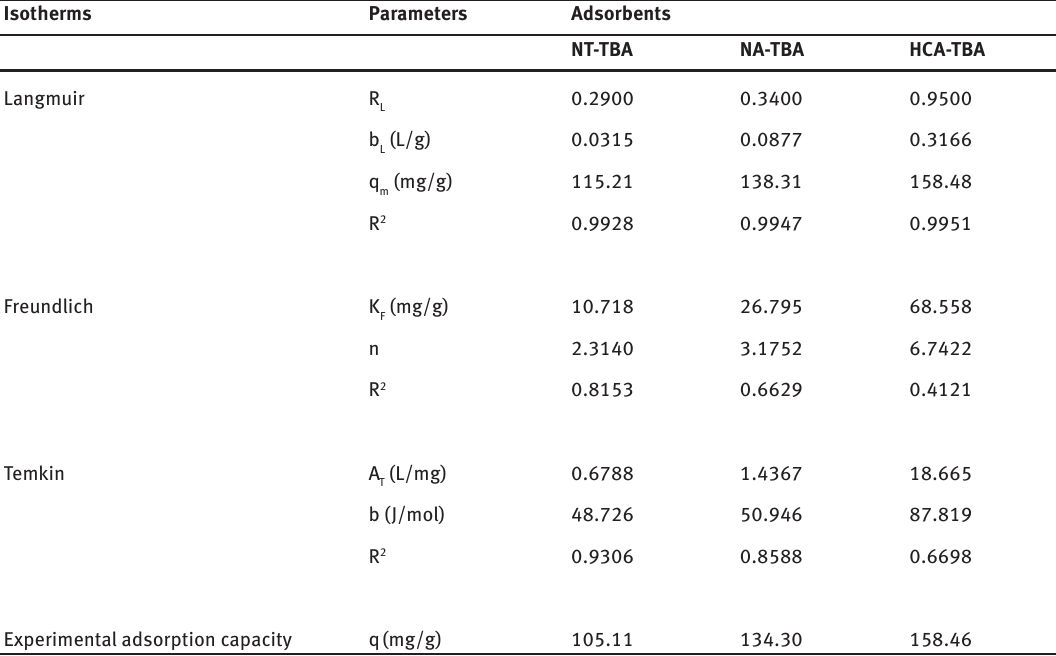
Table 1: Adsorption isotherms parameters for adsorption of Pb(II) by original and chemically pretreated TBP. Isotherms